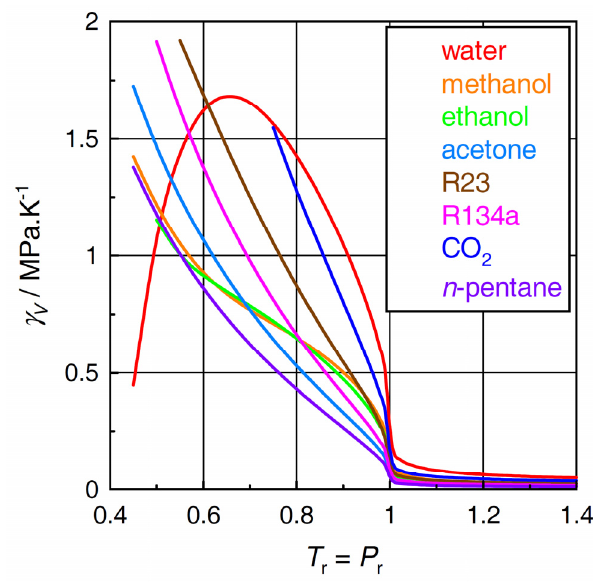
Figure 1. Thermal pressure coefficients γ V of the selected fluids.